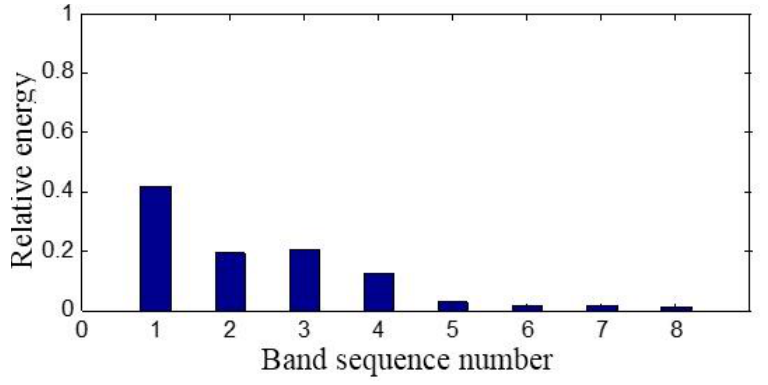
Figure 9. The sensor-dependent signals analyzed by second generation wavelet package in level 3.